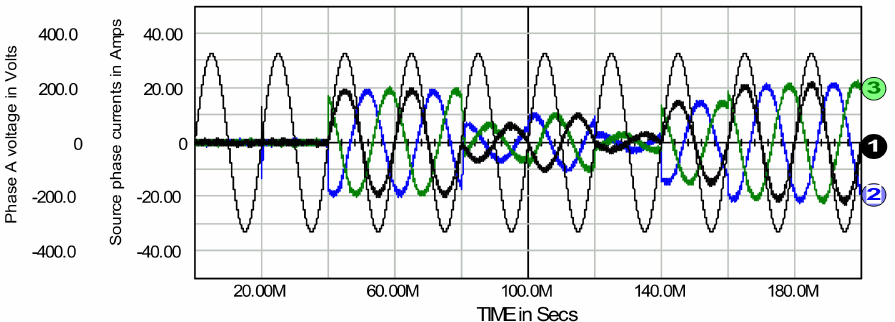
Figure 9. Source phase currents of phase A, B, and C as waveforms 1, 2, and 3, respectively, against the background of phase A source